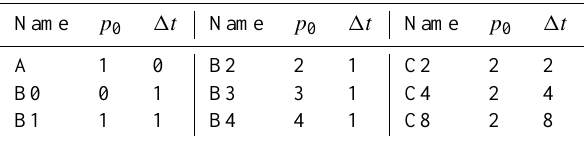
Table 2. Table of